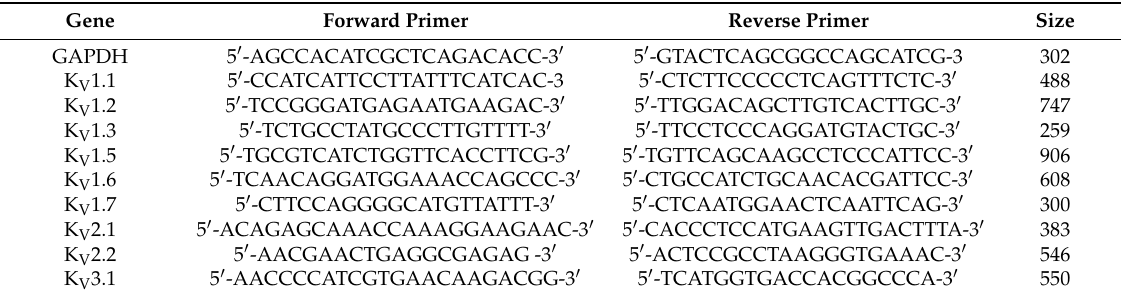
Table 1. Primers of delayed rectifier potassium channels used for RT-PCR.